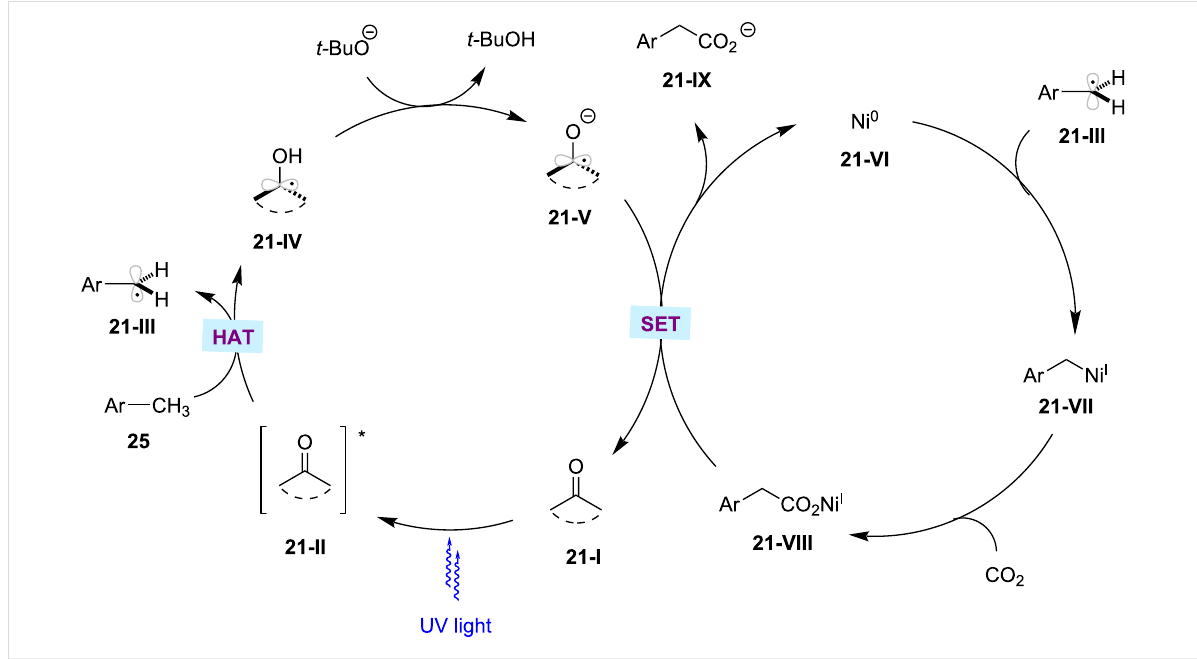
Figure 21: Proposed mechanism for the photoredox carboxylation of methylbenzenes with CO 2 .